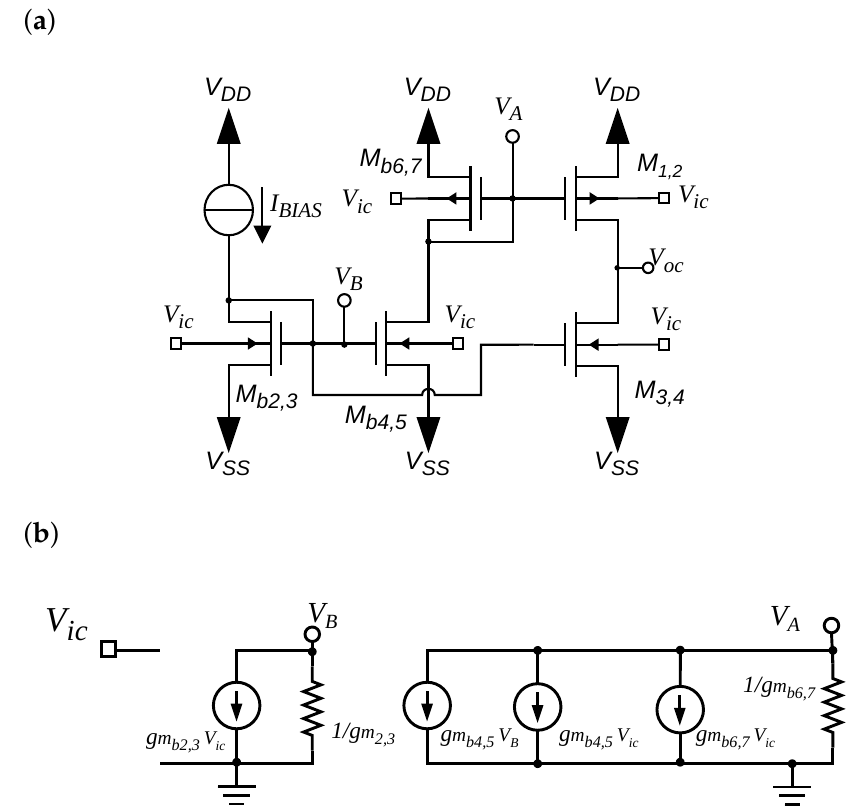
Figure 3. Common mode equivalent circuit of the input stage with replica bias ( a ) and corresponding small signal model ( b ).